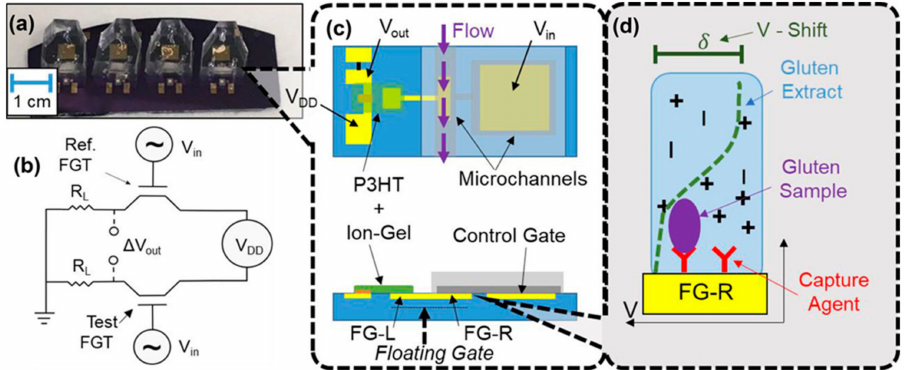
Figure 5. Floating-gate transistor (FGT)-based electronic biosensor structure. ( a ) Image of FGTs. ( b ) Circuit for a pair of FGTs. ( c ) Single FGT schematic showing electrodes, materials, and sample flow. ( d ) Sensor surface modified with antibodies or aptamers on floating-gate electrode (FG-R), upon binding to gluten, a change in the potential occurs (green line) leading to a shift in voltage value (reprinted with permission from Reference [65]. Copyright 2018, American Chemical